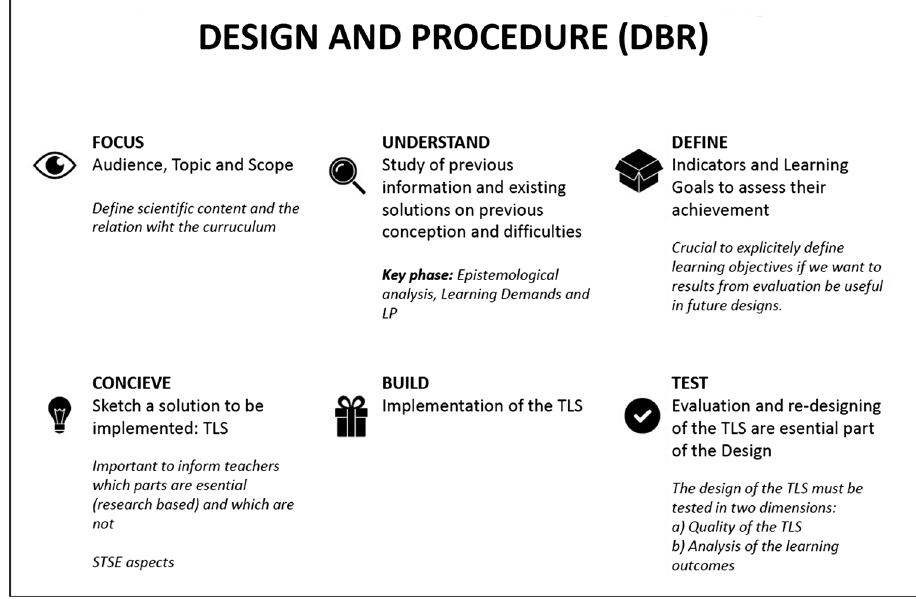
FIG. 1. Different steps of DBR methodology. Adapted from Easterday, Lewis, and Gerber